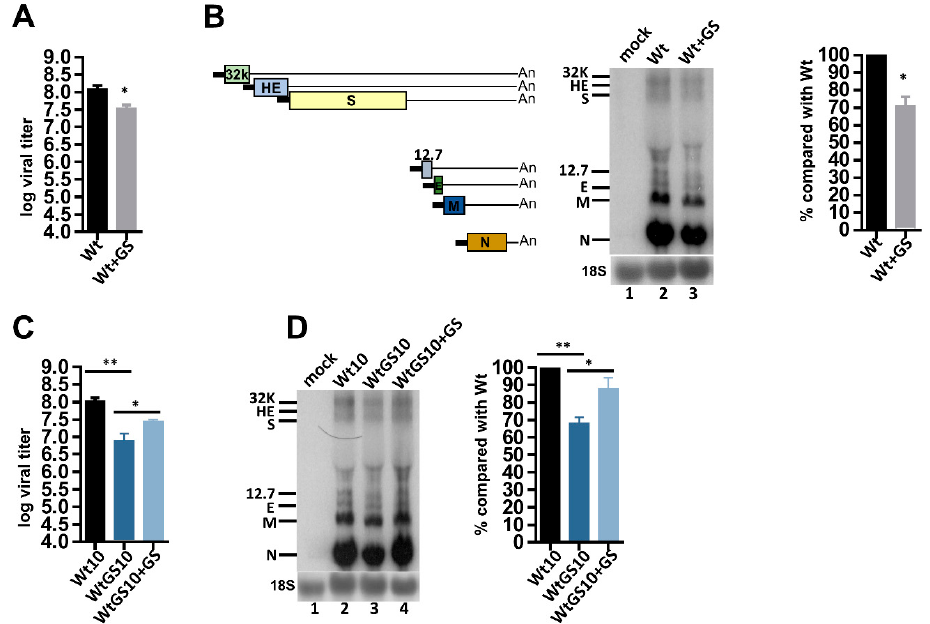
Figure 2. Effects of antiviral remdesivir (GS-5734) on the virus fitness in HRT-18 cells. ( A ) The virus titer of Wt and Wt + GS at VP0 as determined by the plaque assay. Wt indicates the virus collected from wt BCoV-infected HRT-18 cells in the absence of GS-5734. Wt + GS indicates the virus collected from wt BCoV-infected HRT-18 cells in the presence of GS-5734. ( B ) Left panel: Schematic representing the BCoV sgmRNAs. Middle panel: determination of BCoV RNA synthesis from HRT-18 cells infected with wt BCoV in the absence (Wt) or presence (Wt + GS) of GS-5734 at VP0 by Northern blotting. BCoV subgenomes are used to represent the RNA synthesis because the signal of genome is generally weak or not detectable using Northern blotting. 32K: 32 kDa protein, HE: hemagglutinin/esterase, S: spike protein, 12.7: 12.7 kDa protein, E: envelope protein, M: membrane protein, N: nucleocapsid protein. Right panel: Relative amounts of BCoV RNA between Wt and Wt + GS based on the results shown in the middle panel. ( C ) Comparison of the viral titer between viruses collected from Wt10- and WtGS10-infected HRT-18 cells in the absence of GS-5734, and between viruses collected from WtGS10-infected HRT-18 cells in the absence of GS-5734 (i.e., WtGS10) and from WtGS10-infected HRT-18 cells in the presence of GS-5734 (i.e., WtGS10 + GS), as determined by the plaque assay. Wt10 is the virus collected from wt BCoV-infected HRT-18 cells at VP10 in the absence of GS-5734. WtGS10 is the virus collected from wt BCoV-infected HRT-18 cells at VP10 in the presence of GS-5734. ( D ) Left panel: determination of BCoV RNA synthesis from Wt10- and WtGS10-infected HRT-18 cells in the absence of GS-5734 (lanes 2 and 3, respectively), and from WtGS10-infected HRT-18 cells in the presence of GS-5734 (WtGS10 + GS, lane 4) by Northern blotting. Right panel: relative amounts of BCoV RNA based on the results shown in the left panel. 32K: 32 kDa protein, HE: hemagglutinin/esterase, S: spike protein, 12.7: 12.7 kDa protein, E: envelope protein, M: membrane protein, N: nucleocapsid protein, 18S: 18S rRNA, FP: fusion peptide, HR1: heptad repeat 1, HR2: heptad repeat 2. The values in ( A – D ) represent the mean ± standard deviation (SD) of three individual experiments. The statistical significance was evaluated using a paired t -test: * p < 0.05, ** p < 0.01.